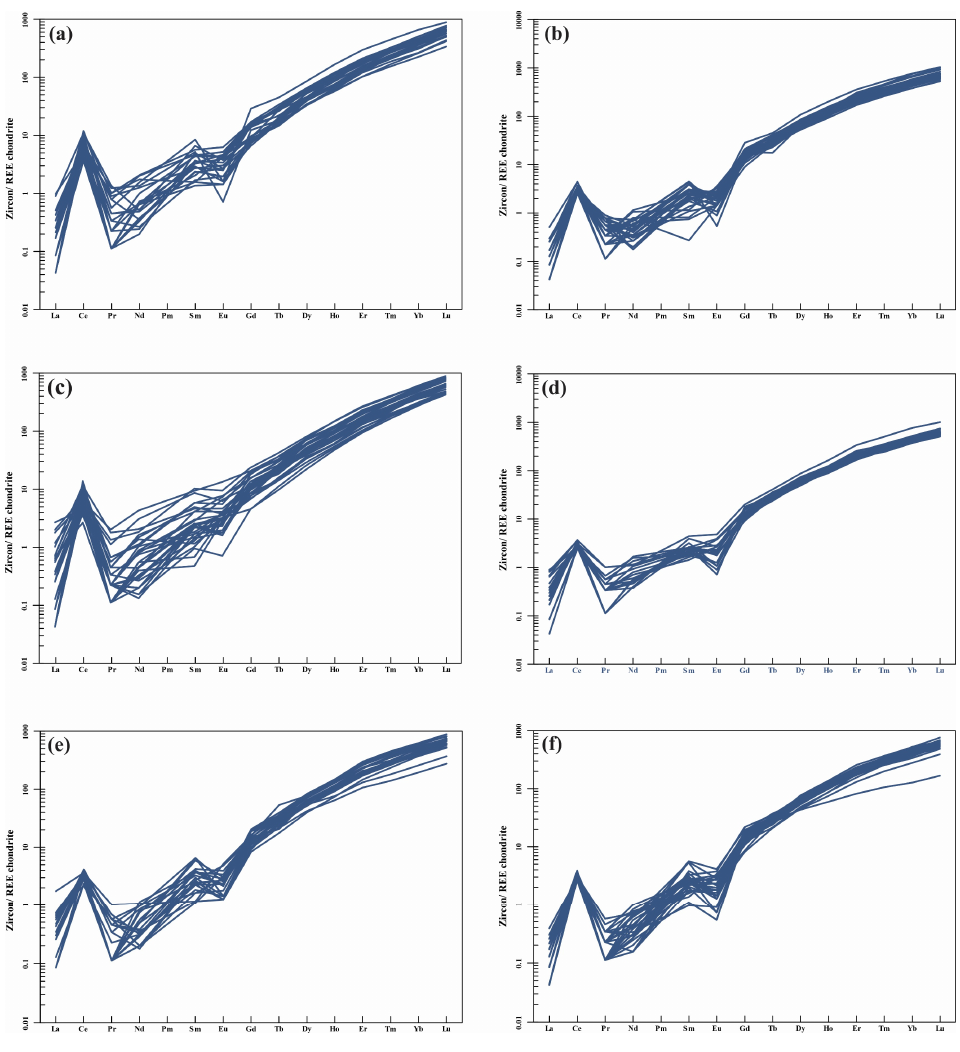
Figure 10. ( a–f ): Chondrite-normalised REE pattern of zircons from gabbros: ( a ) NB8, ( b ) NB15, ( c ) NB17, ( d ) NB20, ( e ) NB36, and ( f ) NB44. ( c ) NB17, ( d ) NB20, ( e ) NB36, and ( f ) NB44.